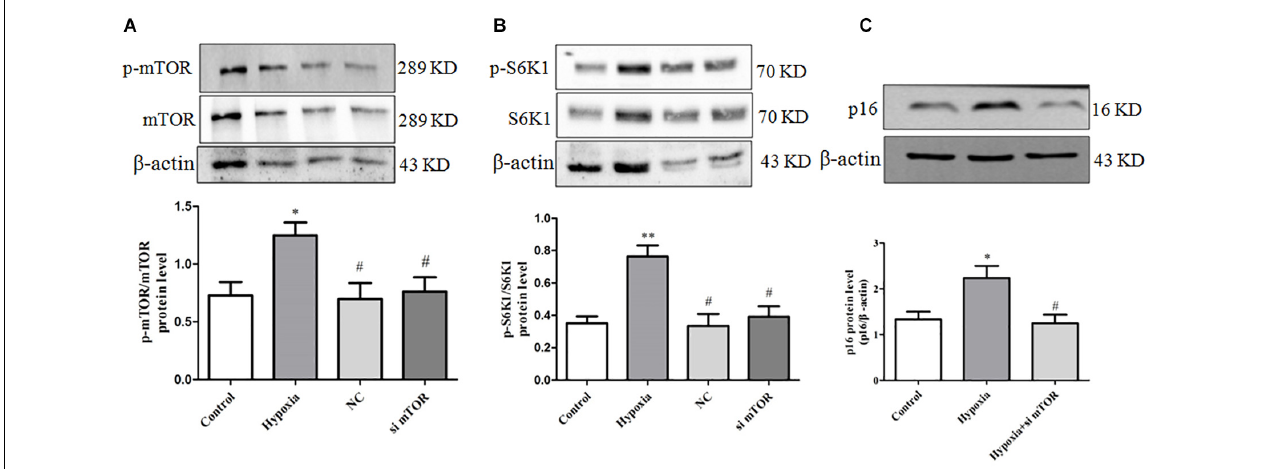
FIGURE 6 | mTOR siRNA can inhibit PASMC senescence by inhibiting the activation of mTOR/S6K1 signaling in hypoxia-treated PASMCs. (A) mTOR siRNA decreased the level of mTOR protein; the protein expression of mTOR was determined by Western blot; statistical result of total gray value was estimated by the image analysis software. (B) mTOR siRNA decreased the level of p-S6K1 and S6K1; the protein expression of p-S6K1 and S6K1 was measured by Western blot; statistical result of total gray value was estimated by the image analysis software. Control: cells were treated with 21% O 2 for 48 h; hypoxia: cells were treated with 3% O 2 for 48 h; + NC: cells were transfected with negative control 50 nM for 4 h before stimulation with hypoxia for 48 h; + mTOR siRNA 50 nM: cells were transfected with mTOR siRNA 50 nM for 4 h before stimulation with hypoxia for 48 h. (C) mTOR siRNA decreased the protein expression of p16; the protein expression of p16 was determined by Western blot; statistical result of total gray value was estimated by the image analysis software. Data are mean ± SEM, n = 3. ∗ P < 0.05 vs. control, ∗∗ P < 0.01 vs. control, # P < 0.05 vs. hypoxia.